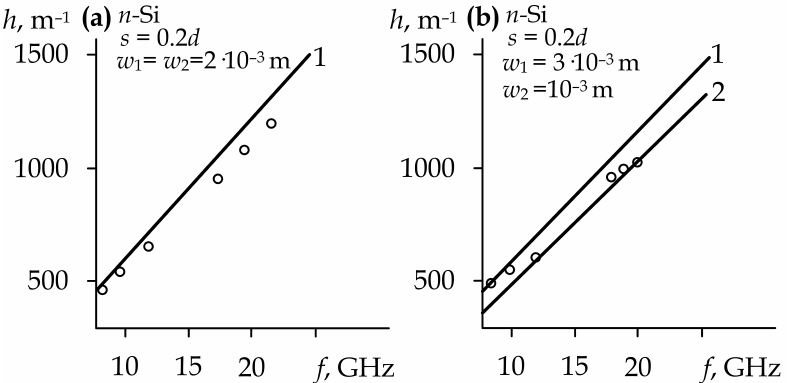
Figure 7. Dispersion characteristics of the slot line (SL) with metal strips placed at the substrate edges for the main mode (curve 1) and the first higher mode (curve 2). ( a ) SL with the same width of strips, ( b ) SL with the width of stripes differs three